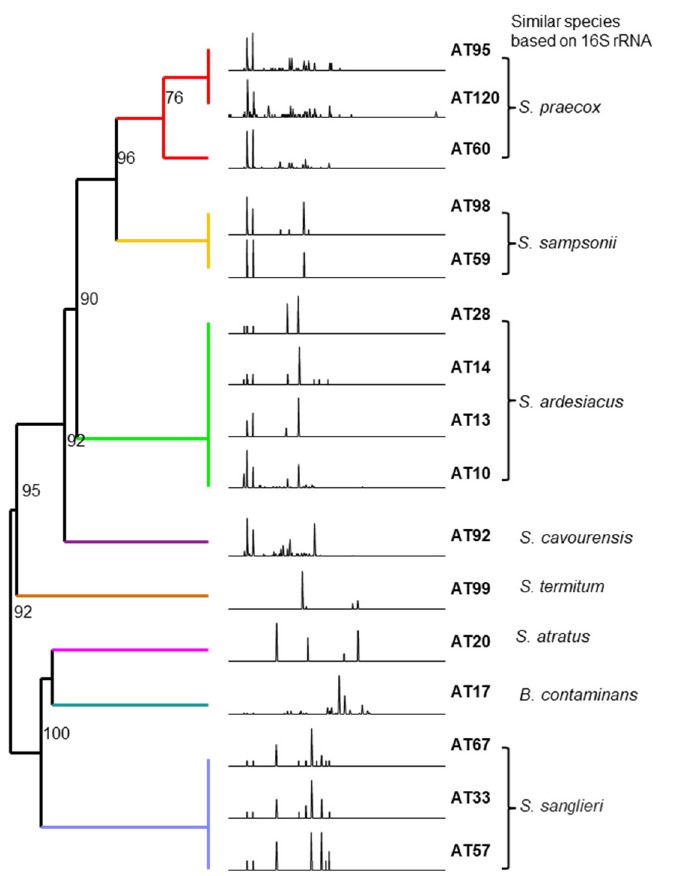
Figure 5. Similarity dendrogram constructed based on HPLC chromatograms with the Dice coefficient and UPGMA method using BioNumerics software.